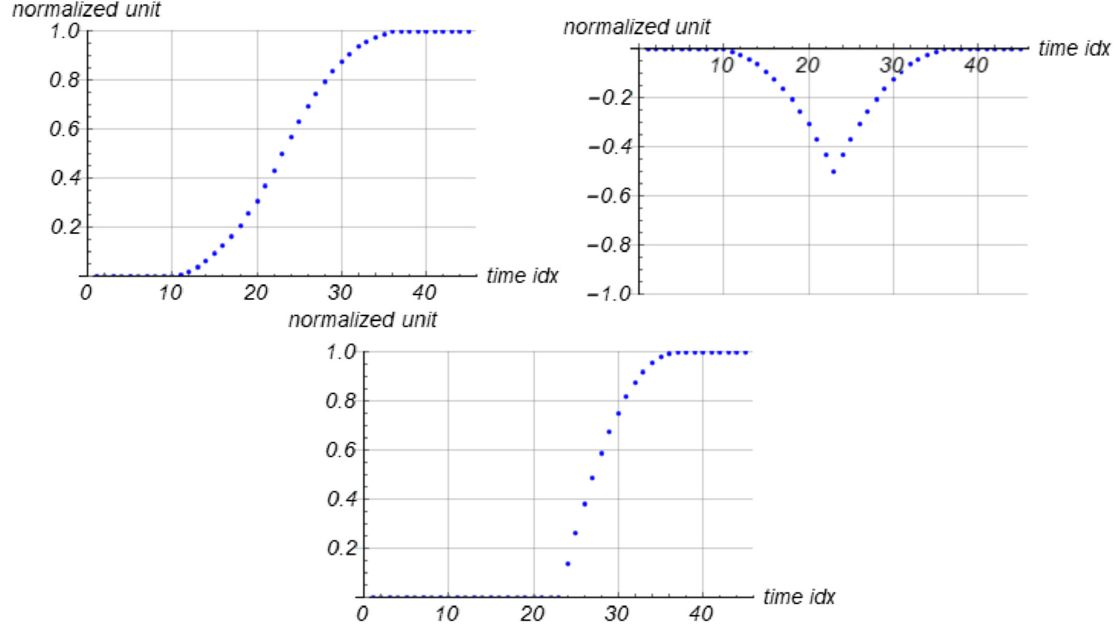
FIG. 28. Step response to beam current (normalized). The time index refers to the 31.25 MHz rate. The top left trace is the response to the real part of the impedance (even-symmetric impulse response), the top right trace shows the odd-symmetric part and the bottom trace is the